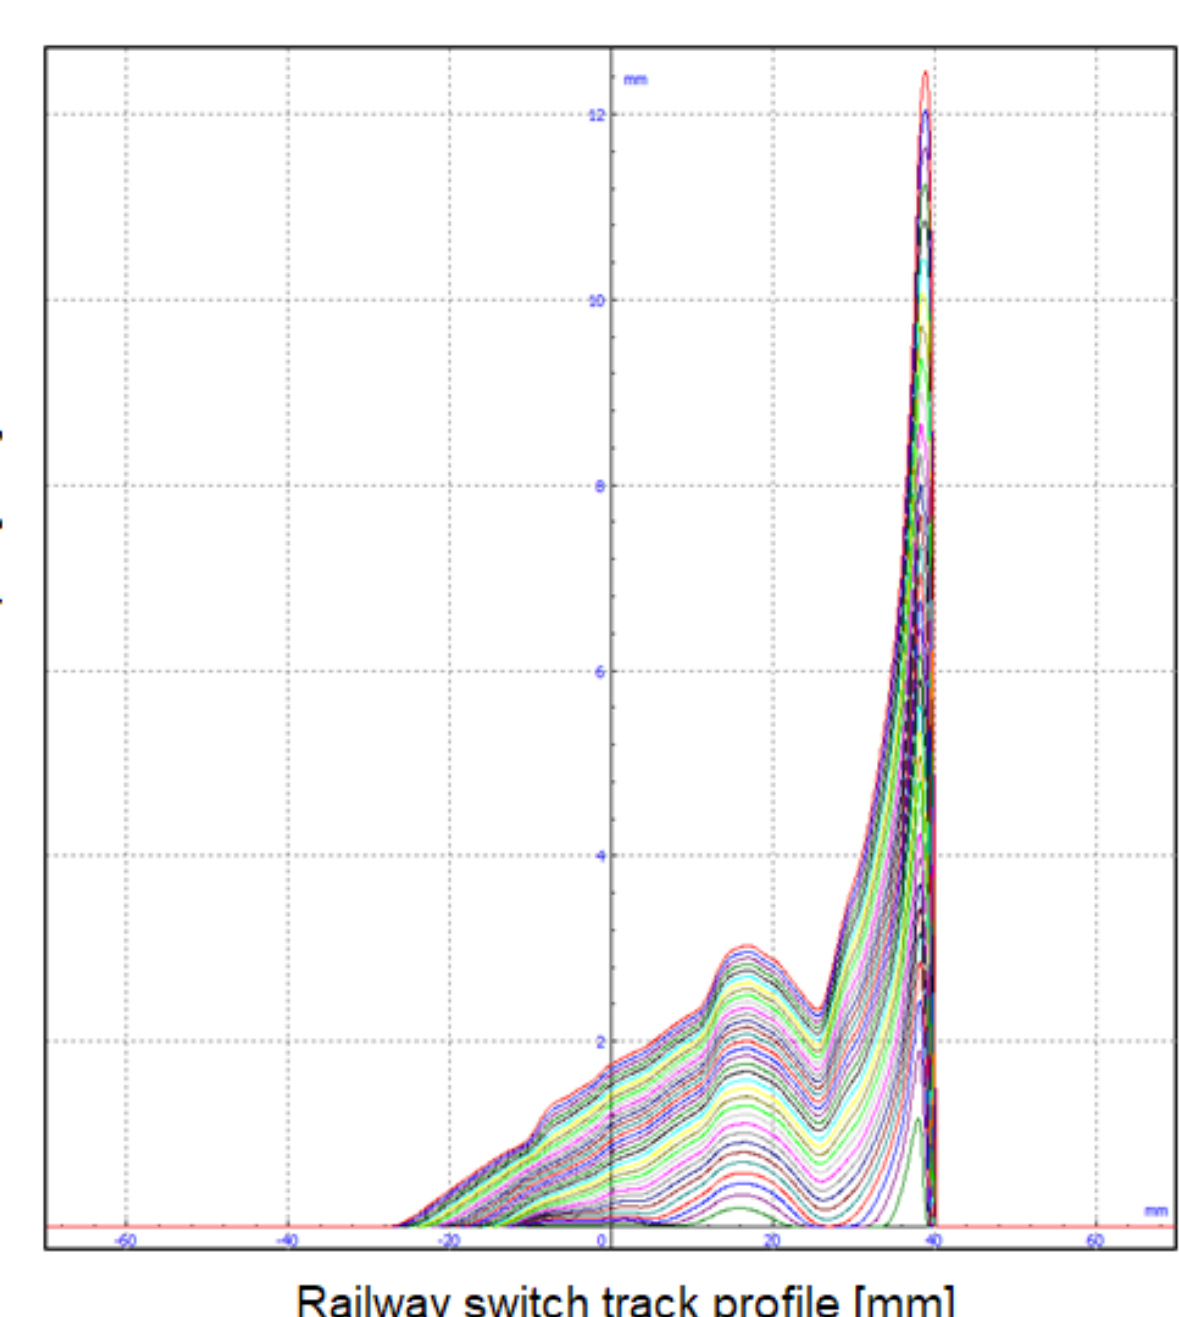
Figure 38. Wear of the first left wheel when a rail vehicle passes a turnout at 200 km/h on a straight track.